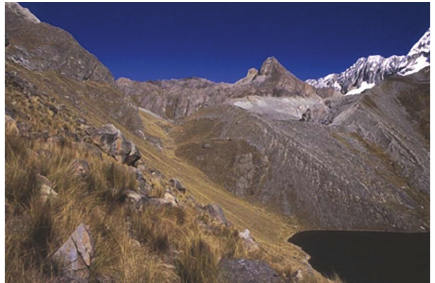
Figure 5: One of the areas that had evidence of continuous use by taruca, note topographic and habitat preferred by the species. Adult and young females were observed in the